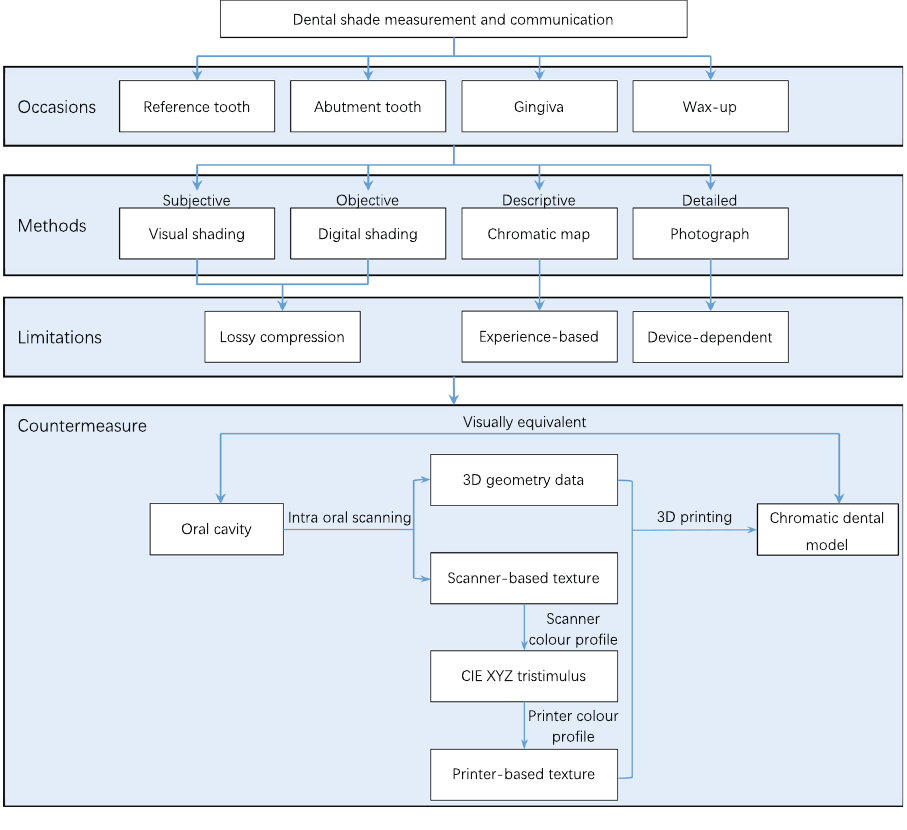
Figure 1. Scheme of the